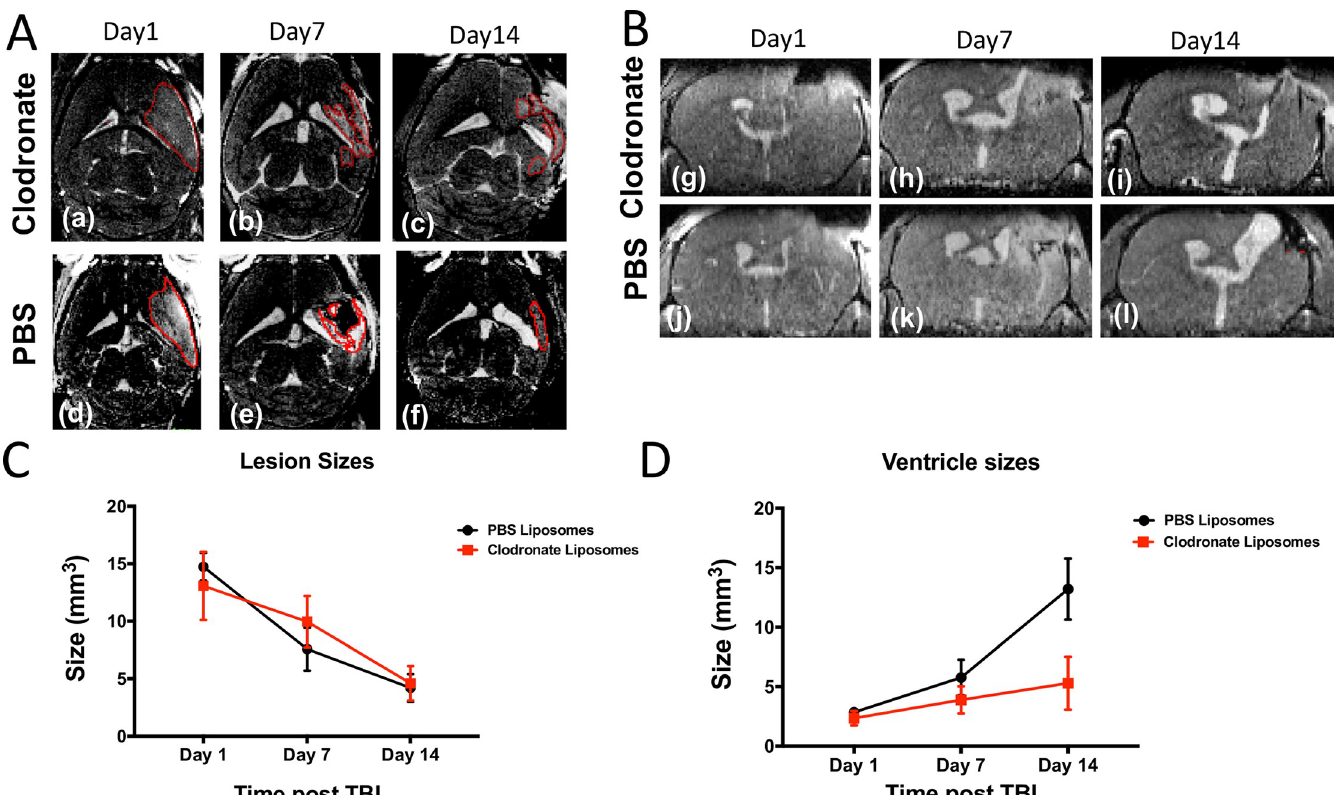
Fig 3. Clodronate-mediated monocyte depletion attenuates ventricle enlargement but not lesion size after traumatic brain injury. A) Representative axial T1W MR images of a TBI/Clodronate treated mouse (a-c) and a TBI/PBS treated mouse (d-f) on post-TBI days 1, 7, and 14. ‘Lesion area’ is outlined in RED. B) Representative coronal T1W MR images of the corresponding TBI/Clodronate treated mouse (g-i) and TBI/PBS treated mouse (j-l) at 1, 7, and 14 days post-TBI. The hyperattenuating area denotes the progressive enlargement of ventricle size over time. C) No significant difference in lesion size was detected at any time point between monocyte-depleted and sham-depleted mice (5 ± 1.1mm 3 vs 7.3 ± 1.06mm 3 ; p = 0.4). D) At 14 days post-TBI clodronate depletion markedly attenuated ventricle enlargement (5.3 ± 0.9mm 3 ) as compared to sham-depleted mice(13.2 ± 3.1mm 3 ; �� p = 0.02).